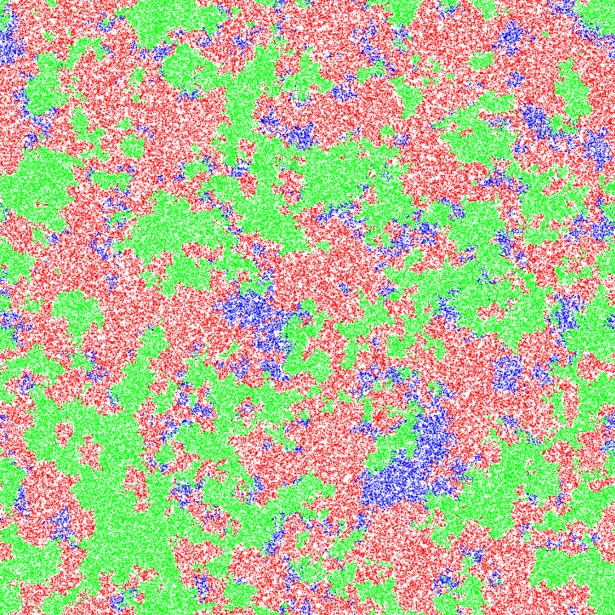
Snapshot showing the spatial structure of the lattice in a case where the three cell types coexist.The snapshot corresponds to the state of the system at time t = 4800 in Fig 1D. Parameters: c = 0.001; a = 150; b = 10; lattice size: L = 1024×1024.